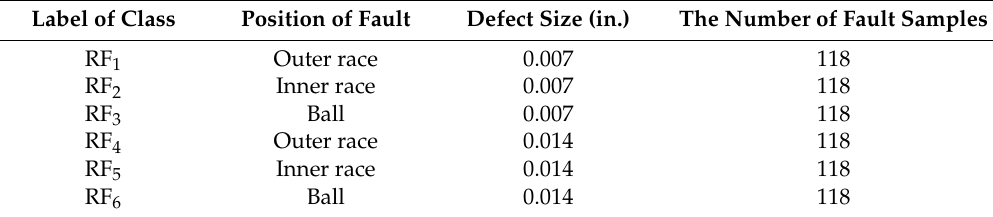
Figure 11 The test stand. Figure 11. The test stand. Table 1. The data set of the rolling element Table 1. The data set of the rolling element bearings. Table 1. The data set of the rolling element bearings.